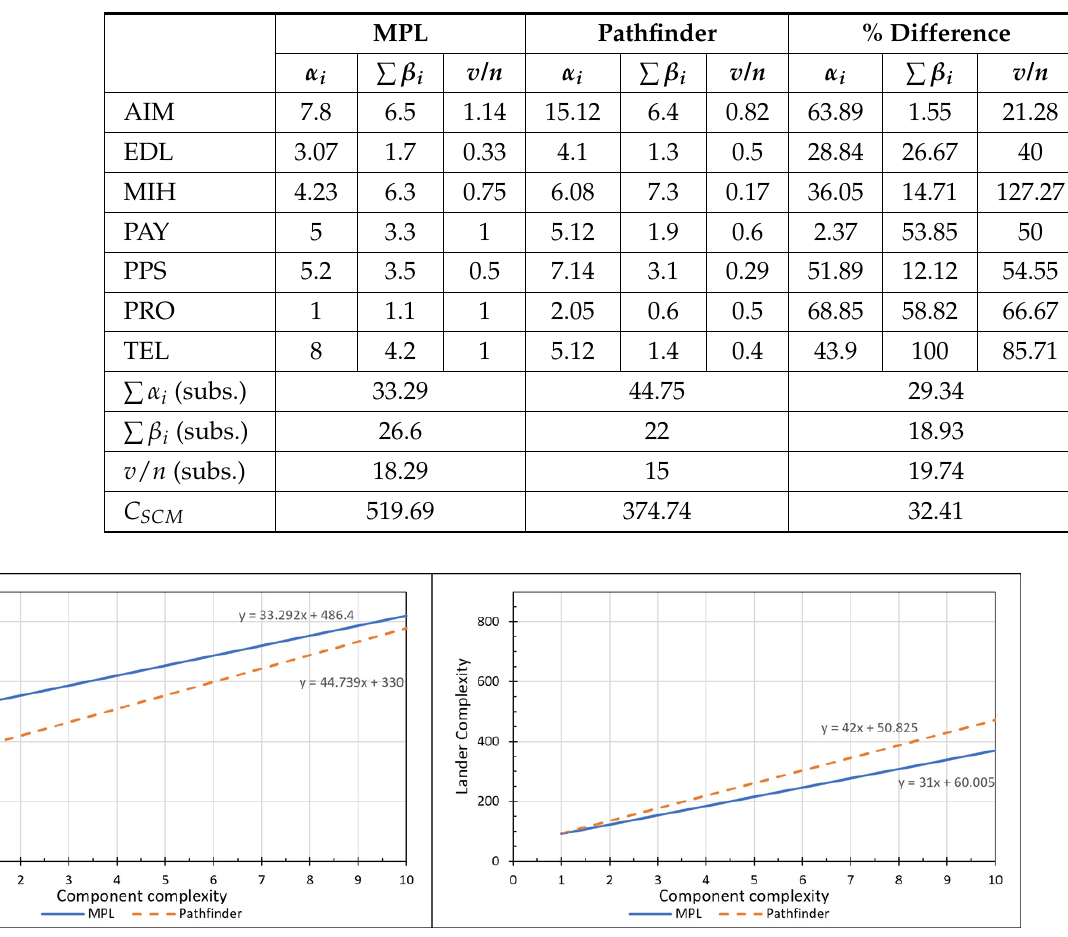
Figure 6. Impact of component complexity, α i , on the lander complexity with the SysML Complexity metric ( left ) and the DSM Complexity metric ( right ).